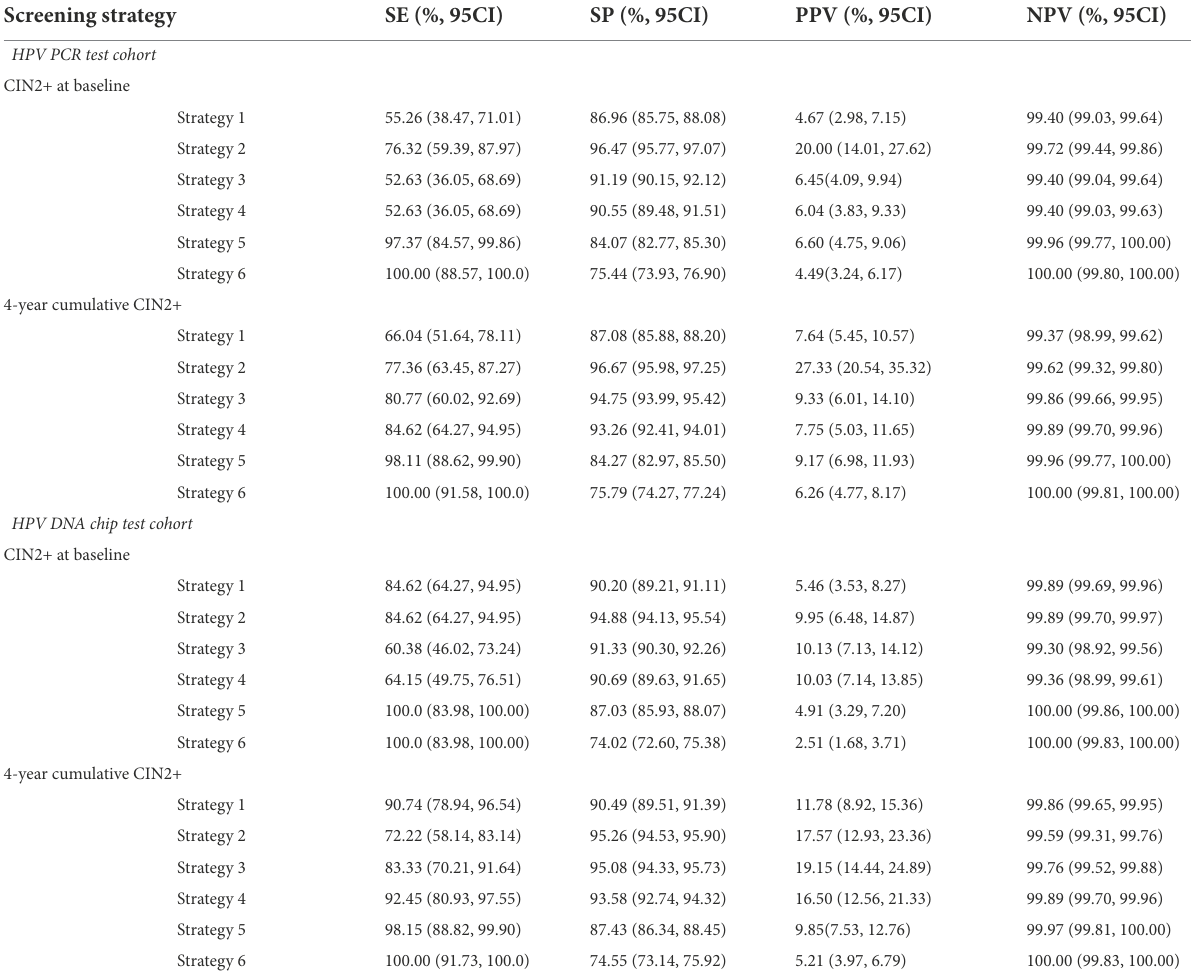
TABLE 3 The sensitivity (SE), specificity (SP), positive predictive value (PPV) and negative predictive value (NPV) of various assays for CIN2+ endpoints. Screening